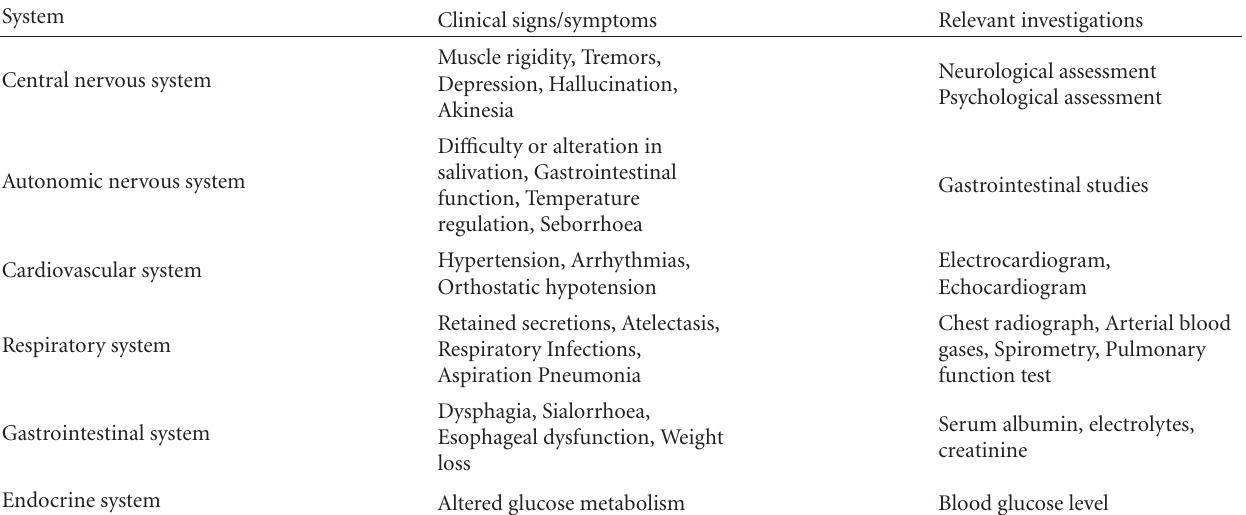
Table 4: Systemic e ff ects of Parkinson’s disease.